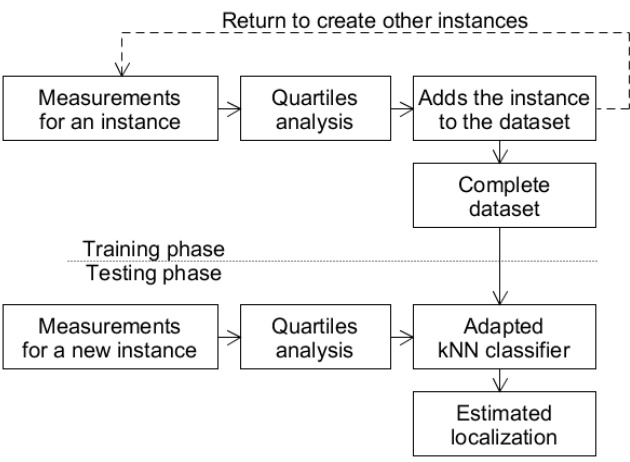
Figure 6. Flow diagram common to methods I and II.